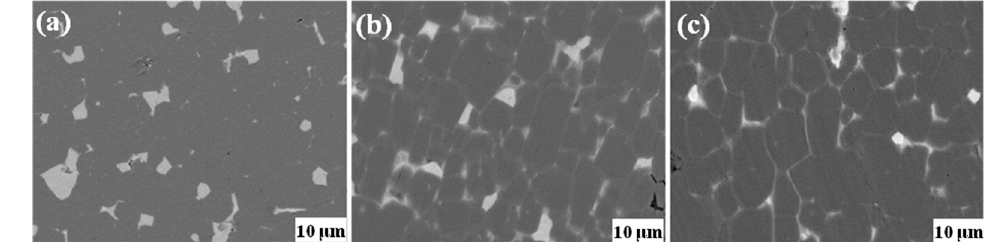
Figure 5. ( a – c ) are BSE-SEM images of the original magnet, and the Dy 70 Al 10 Ga 20 and Figure 5. ( a–c ) are BSE-SEM images of the original magnet, and the Dy 70 Al 10 Ga 20 and (Pr 75 Dy 25 ) 70 Al 10 Ga 20 alloy diffused (Pr 75 Dy 25 ) 70 Al 10 Ga 20 alloy diffused magnets (the surface of observation is the near-surface), respec- magnets (the surface of observation is the near-surface), tively.